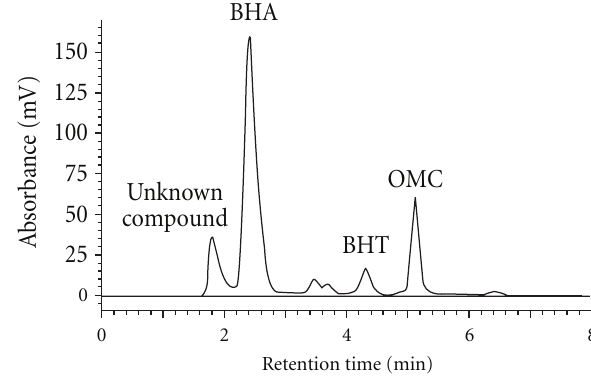
Figure 8: Chromatogram of BHA, BHT, and OMC in De Boy hair gel sample using RP-HPLC-UV/Vis at λ max = 280nm.